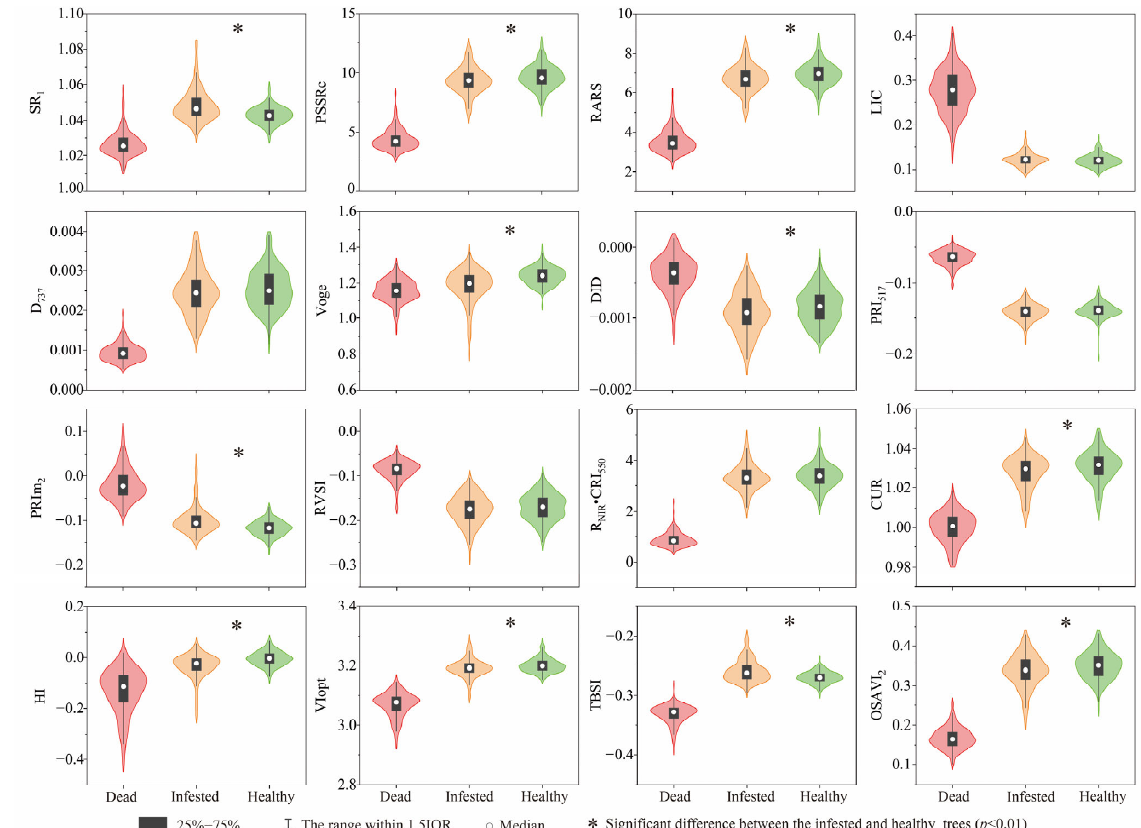
Figure 8. Spectral vegetation indices of three health classes. The symbol * indicates statistically significant differences between healthy and infested trees.